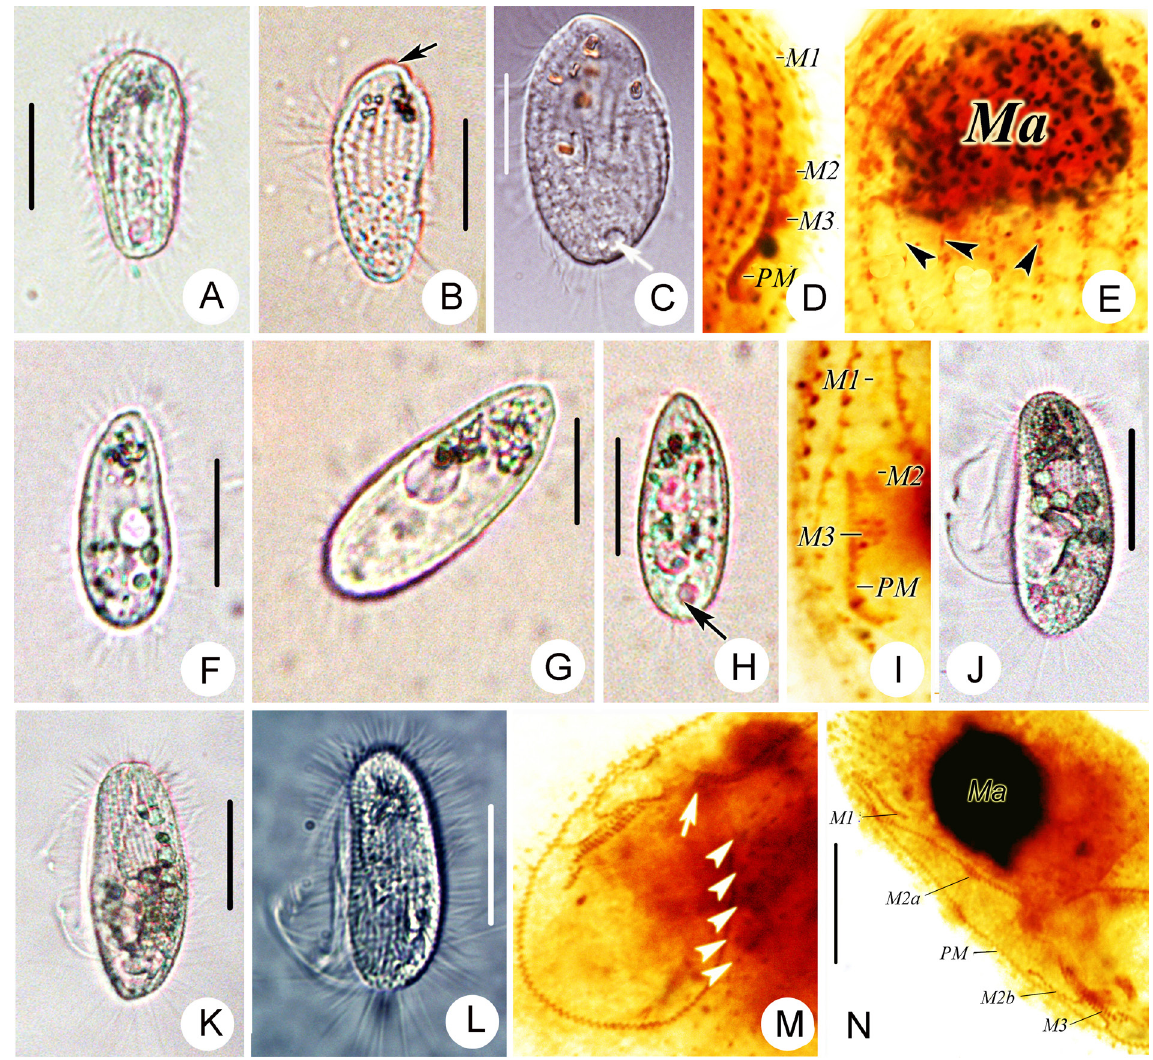
Fig. 4. A – E . Uronemita filificum Kahl, 1931. F – I . Uronema marinum Dujardin, 1841. J – N . Pleuronema setigerum Calkins, 1902. A–C, F–H, J–L. In vivo . D–E, M–N. After silver impregnation. A, F, J . Ventral views of typical individuals. B–C, G–H, K–L . Different individuals, showing variation in body shape, arrow in (B) shows the conspicuous apical plate, arrows in (C, H) mark contractile vacuoles. D, I, M–N . Detailed structures of buccal area, arrow in (M) indicates the ring-like posterior end of M2a, arrowheads in (M) mark preoral kineties. E . Ventral view, arrowheads show somatic kineties. Abbreviations: M1, 2, 3 = membranelle 1, 2 and 3; M2a = the anterior part of membranelle 2; M2b = the posterior part of membranelle 2; Ma = macronucleus; PM = paroral membrane. Scale bars: A–B = 20 μ m; F, H, N = 10 μ m; G = 5 μ m, J–L = 30 μ